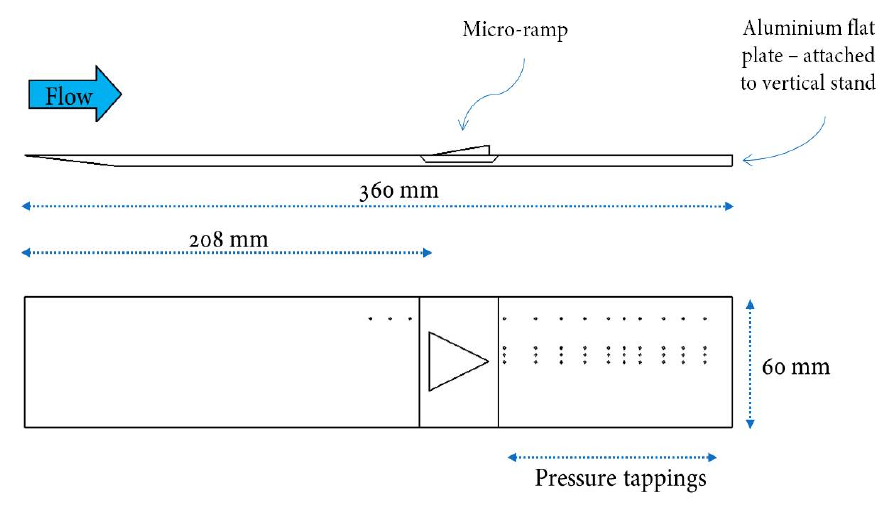
Figure 3. The assembly of micro-ramp with flat plate.